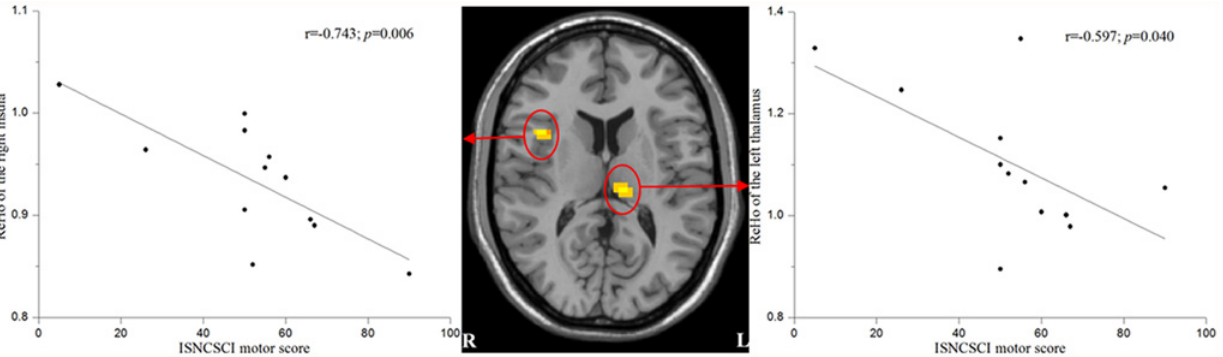
Fig 3. Correlations between the mean ReHo values of the affected regions and ISNCSCI motor scores in patients with acute SCI. Mean ReHo values of the left thalamus and the right insula were negatively correlated with the ISNCSCI motor